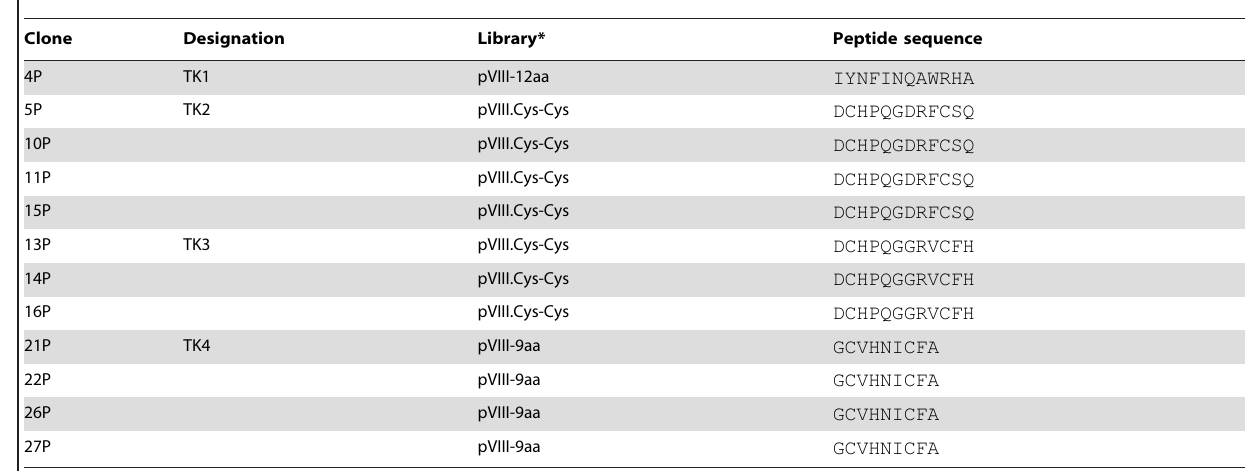
Table 1. Aminoacid sequences of phage inserts from mAb K20-binding clones.